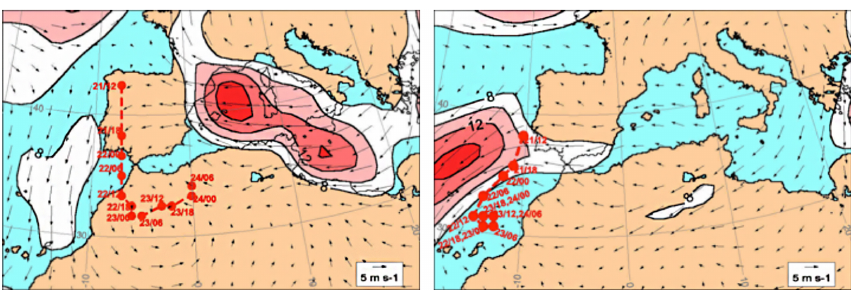
Figure 5. Left panel: position of the cutoff low centre at 300hPa (circled), from 12:00UTC to 06:00UTC (21–24 October 2000), as simulated in the control run. Vector field and shaded contours show the 48h averaged wind and wind speed (ms − 1 ) greater than 8ms − 1 at 1000hPa from 00:00UTC to 00:00UTC (22–24 October 2000). Right panel: the same but for the weakened cutoff low experiment (from Homar et al.,